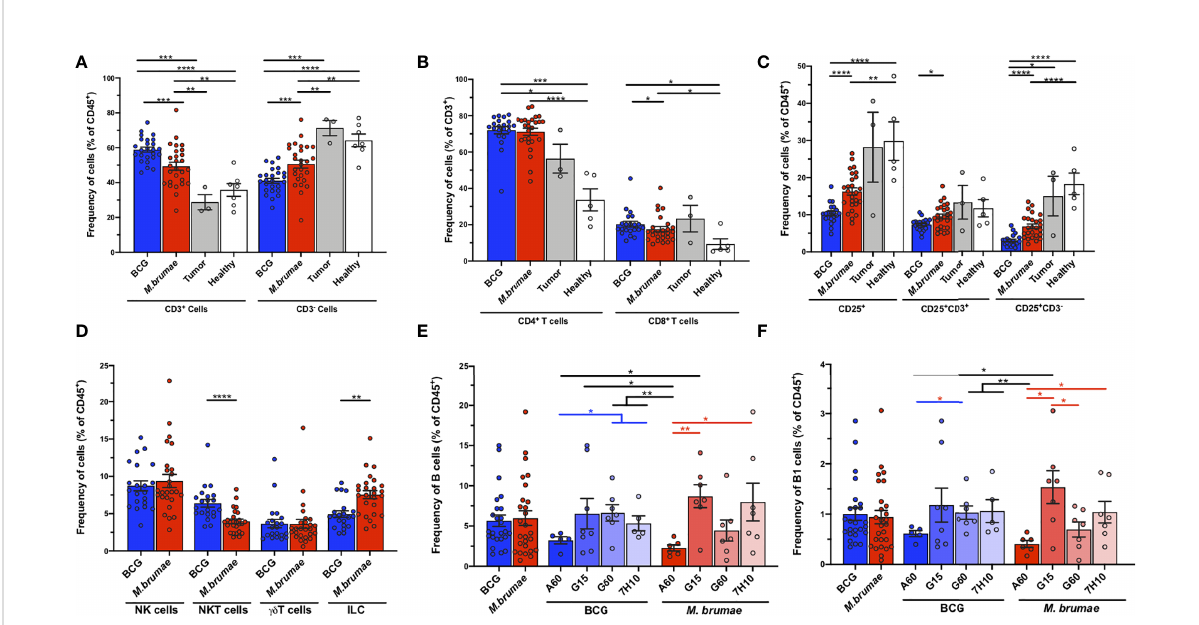
FIGURE 3 T- and non-T in fi ltrating cells into the bladder in different groups of mice. Frequencies of bladder in fi ltrating (A) CD3 + and CD3 - cells; (B) CD4 + and CD8 + T-cells; (C) total CD25-expresing cells, CD3 + CD25 + and CD3 - CD25 + cells; (D) NK, NKT, TCR gd + T-cells and ILC; (E) B-cells; and (F) B1 cells in different groups of mice. Frequencies are given in healthy mice (white bars and dots), untreated tumor-bearing mice (grey bars and dots) and mycobacteria treated-tumor bearing mice, either using BCG (blue bars and dots) or M. brumae (red bars and dots) as percentages of the total live CD45 + in fi ltrating immune cells. Data represent the mean (bars) and ± SEM (error bars) and each dot represent an individual mouse. Statistically signi fi cant differences between the different BCG and M. brumae mycobacteria (intrastrain) are shown as blue and red lines, respectively. Interstrain differences or with the untreated groups (healthy and tumor) are shown in black. Differences were tested using Mann- Whitney U nonparametric test. *p ≤ 0.05; **p ≤ 0.01; ***p ≤ 0.001; ****p ≤